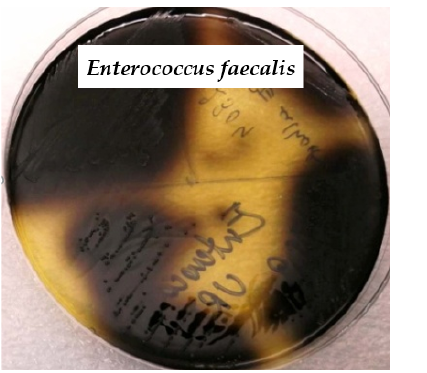
Figure 2. Streptococcus agalactiae , beta-hemolytic, Columbia Figure 3. Colonies of Enterococcus faecalis on